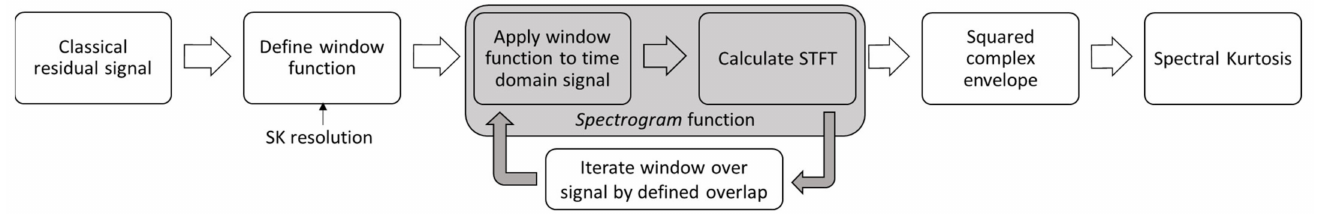
Figure 10. Flowchart of evaluating the Spectral Kurtosis from the classical residual (see Section 2 for further detail).